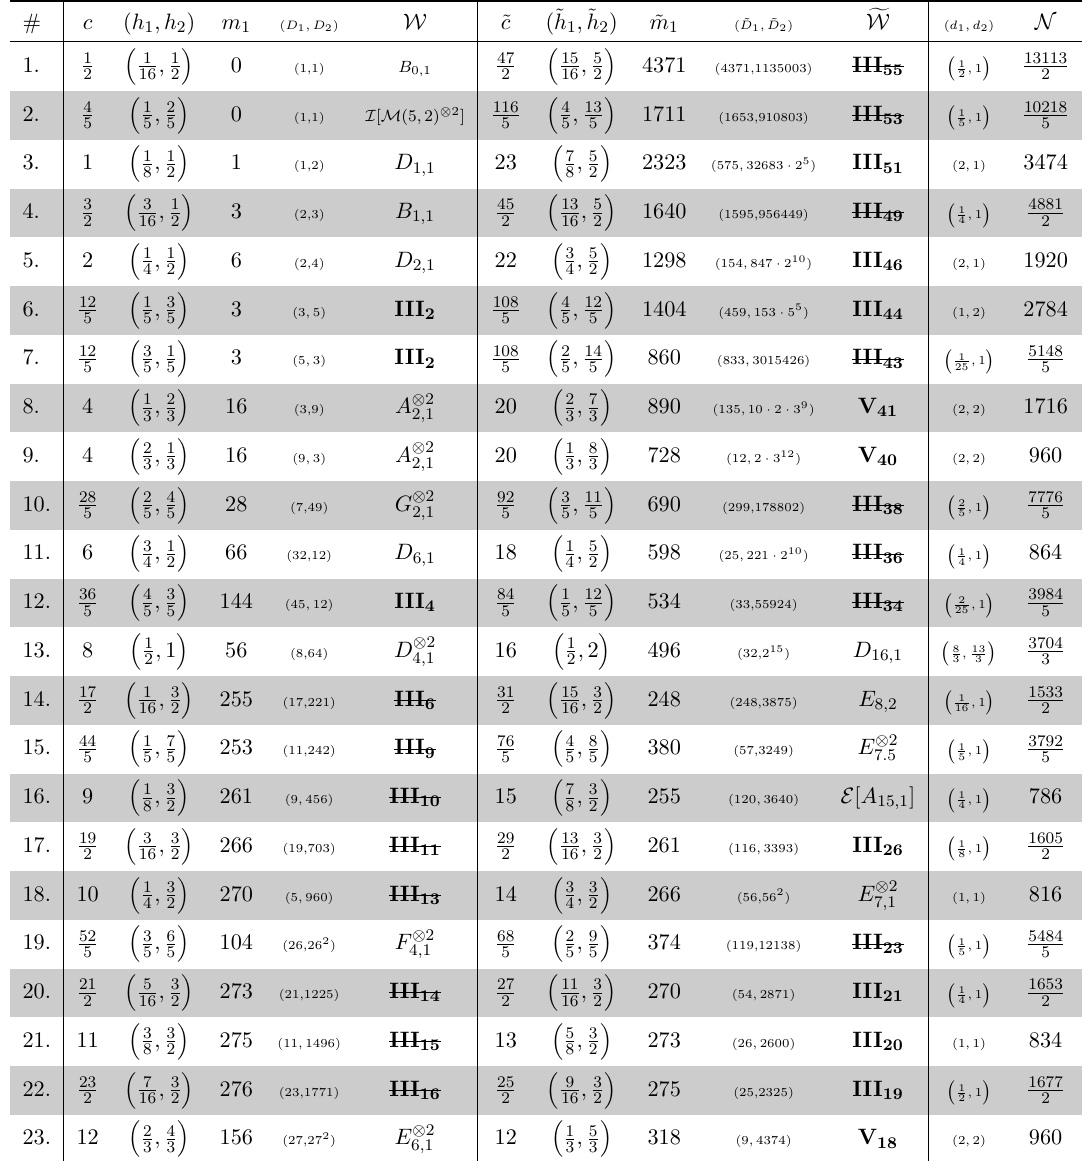
Table 12. Inconsistent pairings, c H = 24 with ( n 1 , n 2 ) = (1 , 3) . The integer N in the last column gives the total number of dimension-1 states in the meromorphic character j − 744 + N